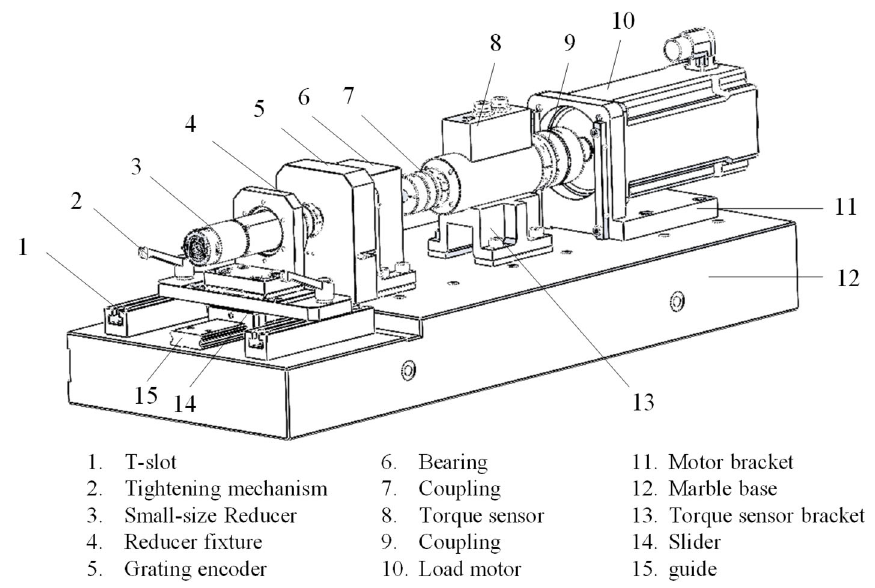
Figure 13. Structure of testing machine.